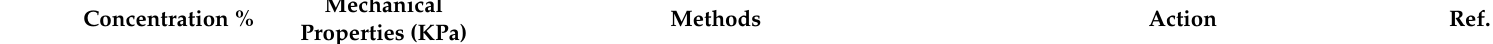
Low-concentration agarose stimulates the formation of more Homogeneous ECM distribution. The presence of TGF-b3 is also beneficial because it stimulates the distribution of matrix